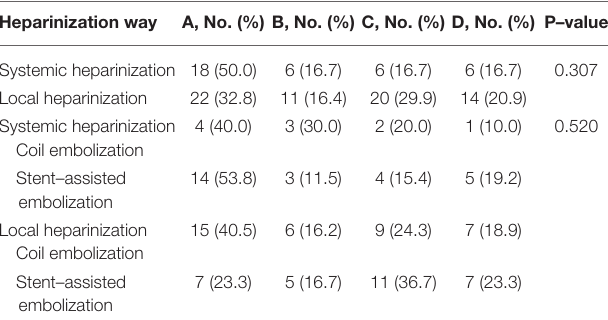
TABLE 3 | Distribution results of the heparinization method and DWI